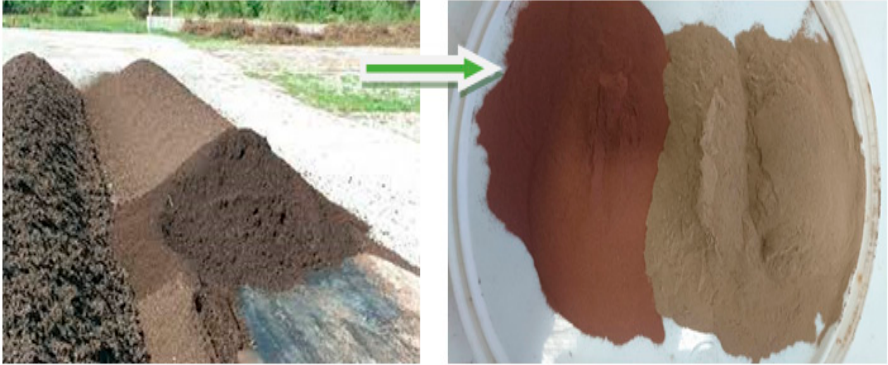
Figure 1. Converted sludge to fly ash from the thermal treatment of sewage sludge—SSA.